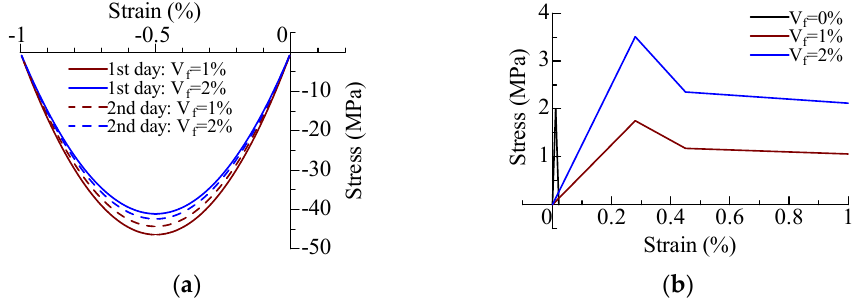
Figure 9. Stress-strain model for section analysis: ( a ) compression side; ( b ) tension side.